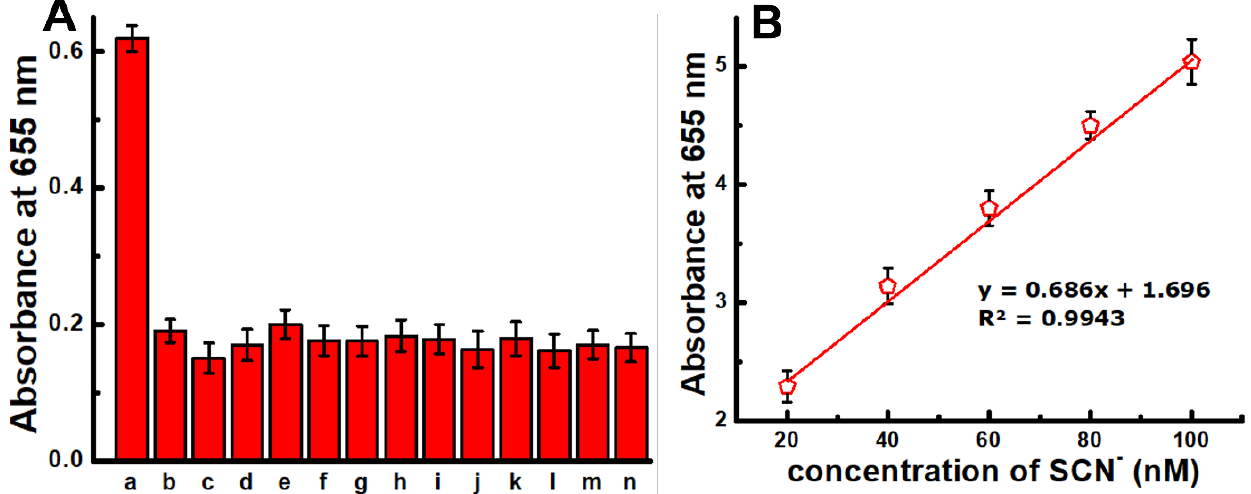
Figure 7. The specificity and SCN − detection in spiked milk samples: ( A ) specificity of the proposed assay (a: SCN − , b: sucrose, c: citrate, d: BSA, e: fructose, f: SO 42− , g: Mg 2+ , h: Ca 2+ , i: EDTA, j: l -lysine, k: CO 32− , l: NO 3− , m: CH 3 CO − , n : Cl − ); ( B ) SCN - concentration vs. absorbance intensity curve measured in the spiked milk samples.